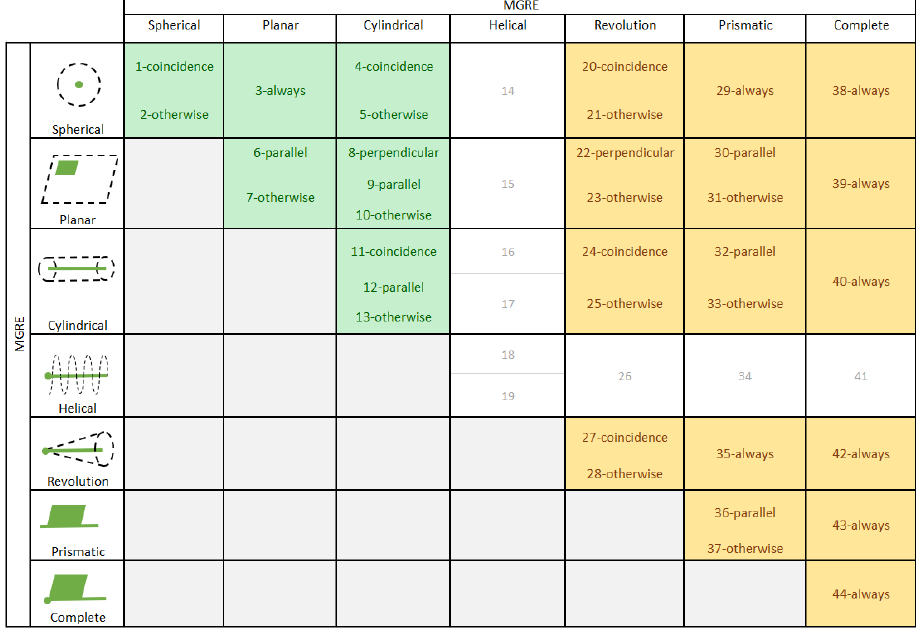
Figure 2. The 44 association types between MGREs.